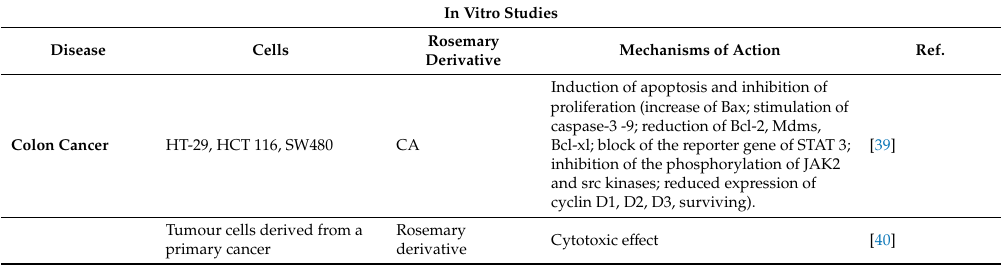
Table 2. In vitro studies on the antineoplastic e ff ects of